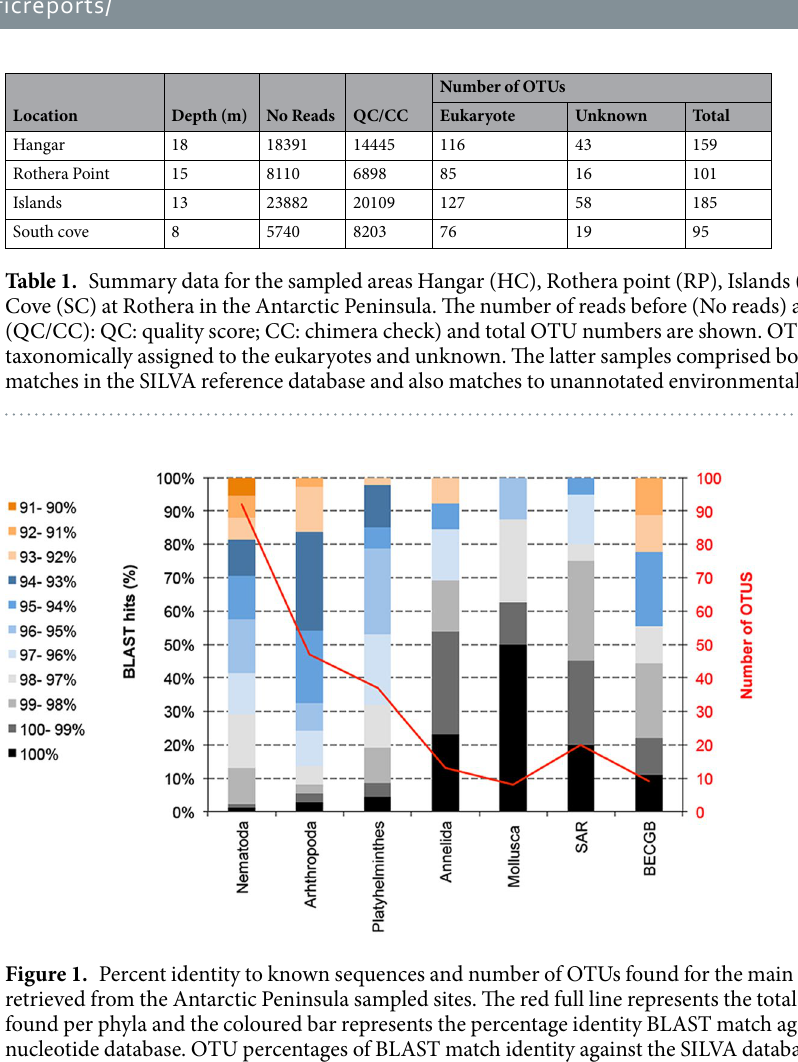
Community composition by number of OTUs did not show significant differences between the sites, with the nematodes totalling ca 30–50 OTUs (Kruskal-Wallis, p = 0.189) followed by the arthropods with ca. 20–30 OTUs (Kruskal-Wallis, p = 0.901), the platyhelminthes with ca. 10–20 (Kruskal-Wallis, p = 0.494), OTUs and the anne- lids with ca. 3–9 OTUS (Kruskal-Wallis, p = 0.110), found in the Antarctic meiobenthic samples (Supplementary Figure S2). In fact, the majority of the samples showed that 90–100% of the OTUs were shared between sites, with the exception of one of the triplicates of the Islands sample that had approximately 30% of unique OTUs (Fig. 3). Whilst all sites showed globally very similar communities, cluster analysis for taxonomic patterns of meiofaunal communities based on Sørensen similarities of OTU presence/absence data for the combined sites showed two well-defined groups within the Antarctic Peninsula sampling sites (Supplementary Figure S3). The Islands and Hangar Cove were more similar to each other, sharing approximately 20% more OTUs than with South Cove and Rothera Point (data not shown). Graphical representation of community composition from all sample sites was visualized with the Krona chart (Fig. 4A). Here, the eukaryotic taxonomic composition of all sites combined showed that the nematodes com- prised 32% of the total eukaryotic OTUs. Followed by the arthropods, platyhelminthes and annelids with 18%, 12% and 4% representing the total eukaryotic biodiversity, respectively. Within the nematodes two taxonomic classes predominated: the Chromadorea (80% OTUs) and the Enoplea (20% OTUs) (Fig. 4B, Supplementary Table S1.1–S1.3, Supplementary Material S1). Within these two taxa, Monhysterida (37% OTUs) and Enoplida (19% OTUs) comprised the major proportion of the identifications respectively (Fig. 4B, Supplementary Table S1.1–S1.3). Copepoda dominated the arthropods with 87% of the identified OTUs. The Harpacticoida were particularly abundant at 76% of the Copepoda (Fig. 4b, Supplementary Table S1.1–S1.3, Supplementary